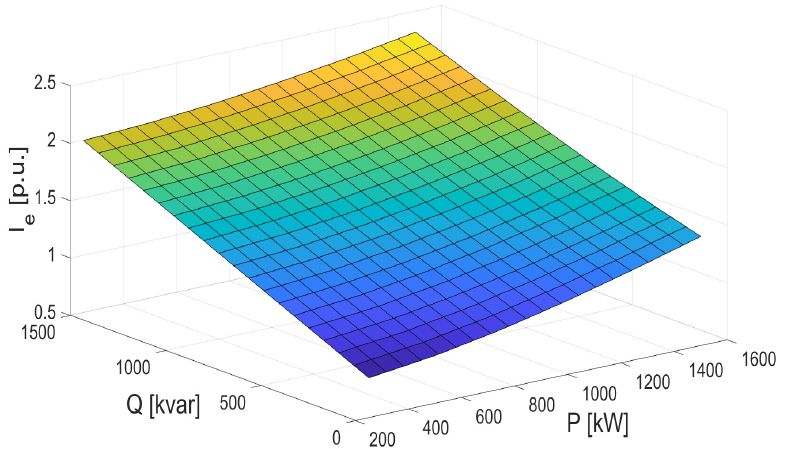
Figure 10. Simulation results. Per-unit exciter field current ( I e ) simulation results for different [P,Q] operating points at reference output voltage ( U = 400 V or 1 p.u. ) in healthy conditions.